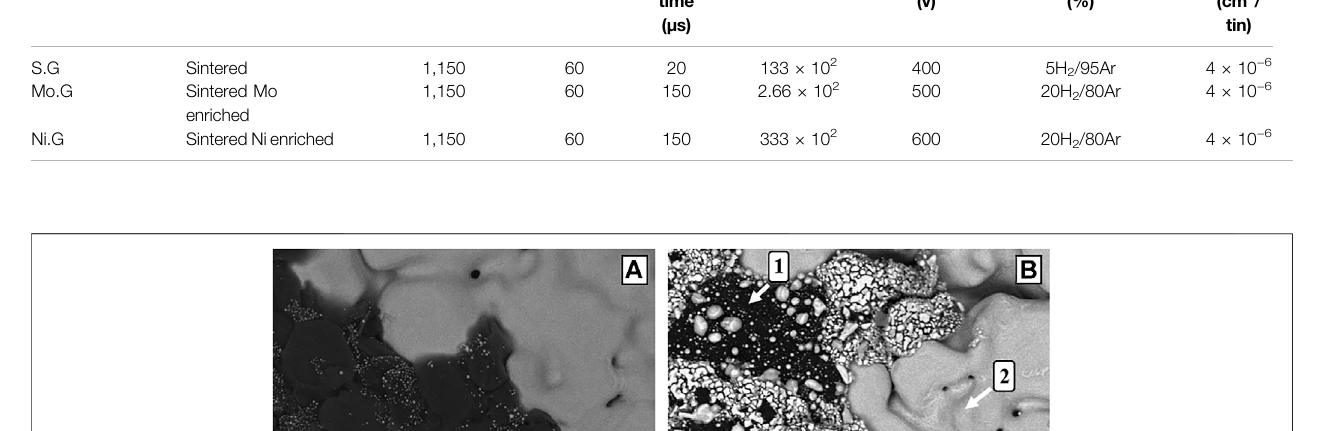
Frontiers in Mechanical Engineering |